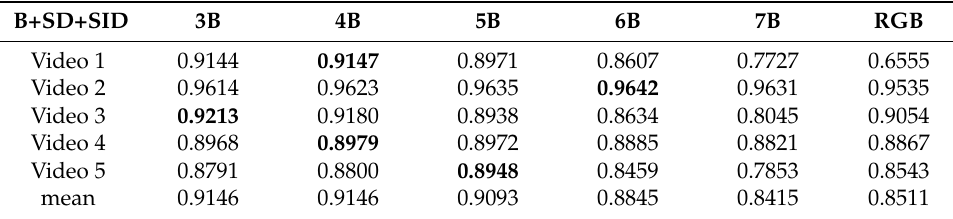
Table 4. Best F-measures with B+SD+SID on five videos.